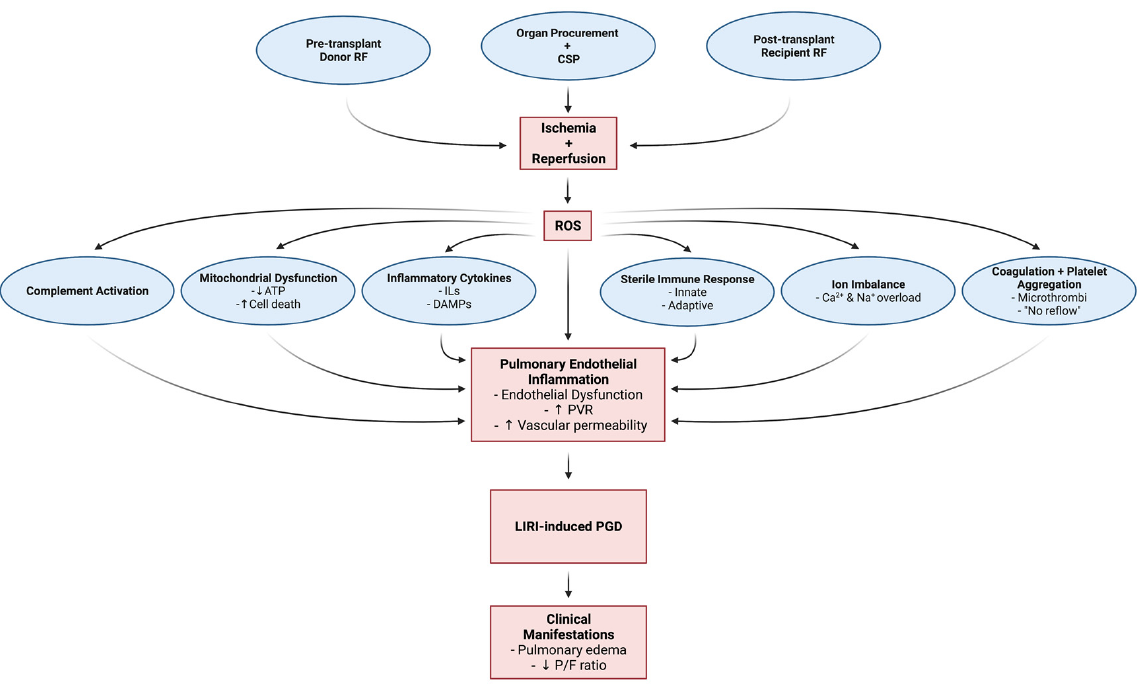
Figure 1. Factors and cellular mechanisms associated with lung ischemic reperfusion injury and primary graft dysfunction in lung transplantation. Risk Factors, RF; Cold Static Preservation, CSP; Reactive Oxygen Species, ROS; Adenosine Triphosphate, ATP; Interleukins, ILs; Damage Associated Molecular Patterns, DAMPs; Pulmonary Vascular Resistance, PVR; Lung Ischemic Reperfusion Injury, LIRI; Primary Graft Dysfunction, PGD; PaO 2 /FiO 2 ratio, P/F ratio. Created with BioRender.com.